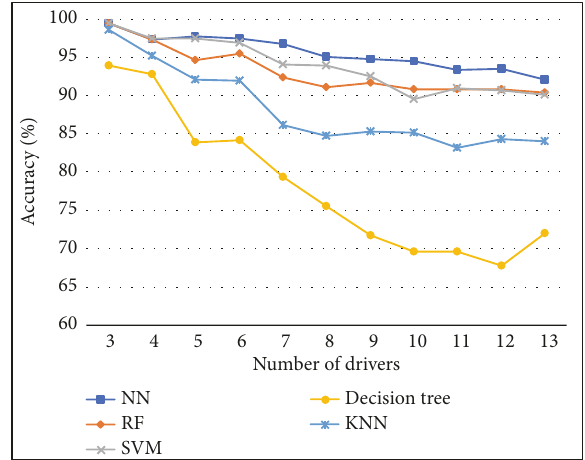
Figure 15: Plot of the accuracy across algorithms and number of